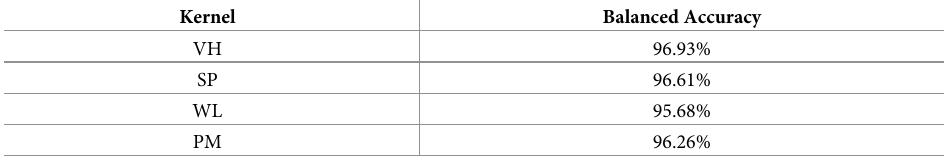
Table 4. Eukaryotes test: Evaluation of SVM prediction results for discerning